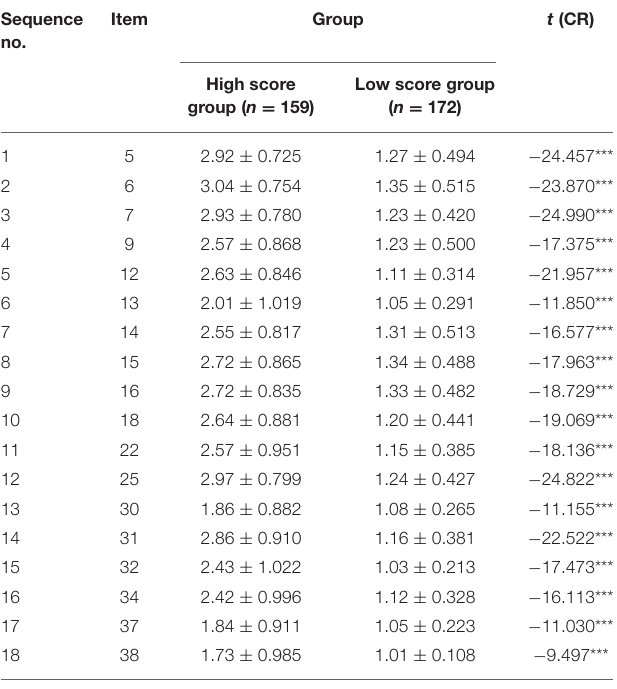
TABLE 2 | Items and factor loadings of the Gaming Hazard Assessment Scale based on exploratory factor analyses (sample 1, n = 572).